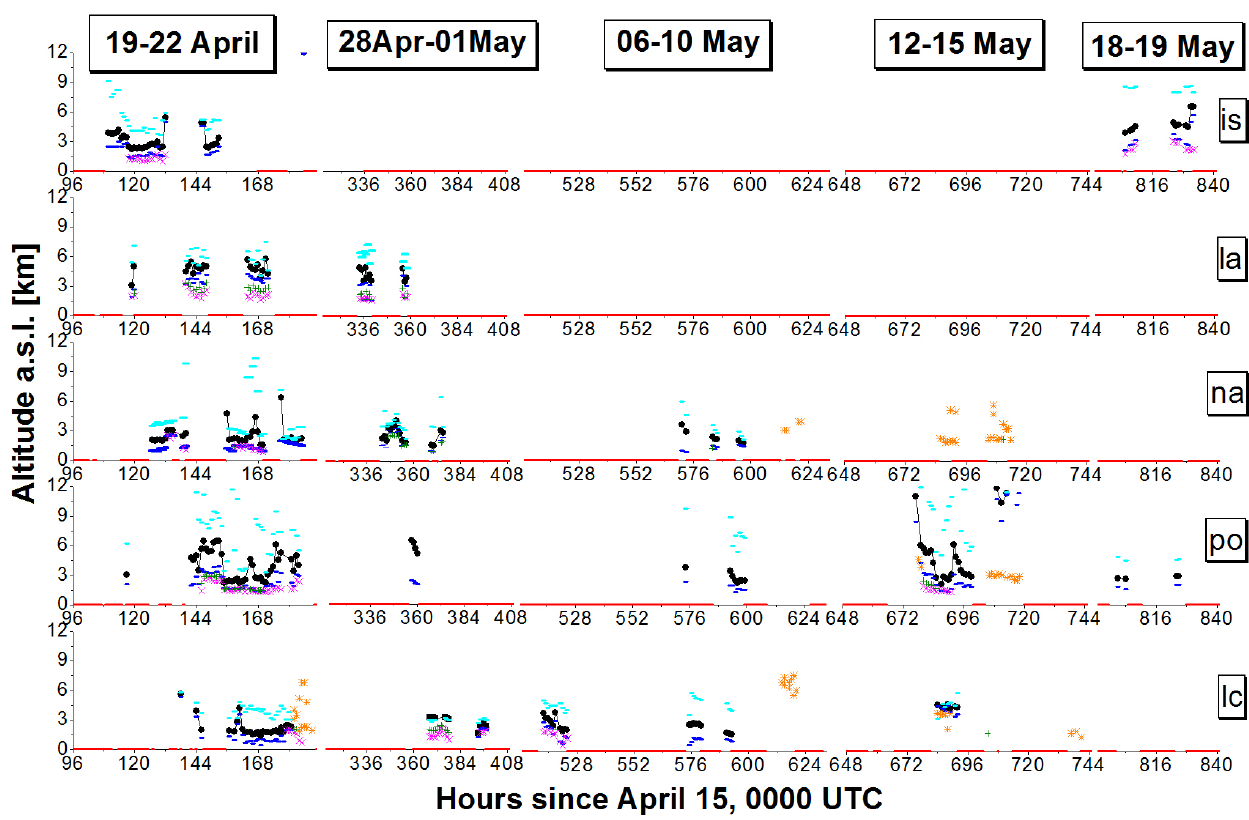
Fig. 6. As Fig. 5 for Central Mediterranean cluster: Ispra (is), L’Aquila (la), Naples (na), Potenza (po) and Lecce (lc).